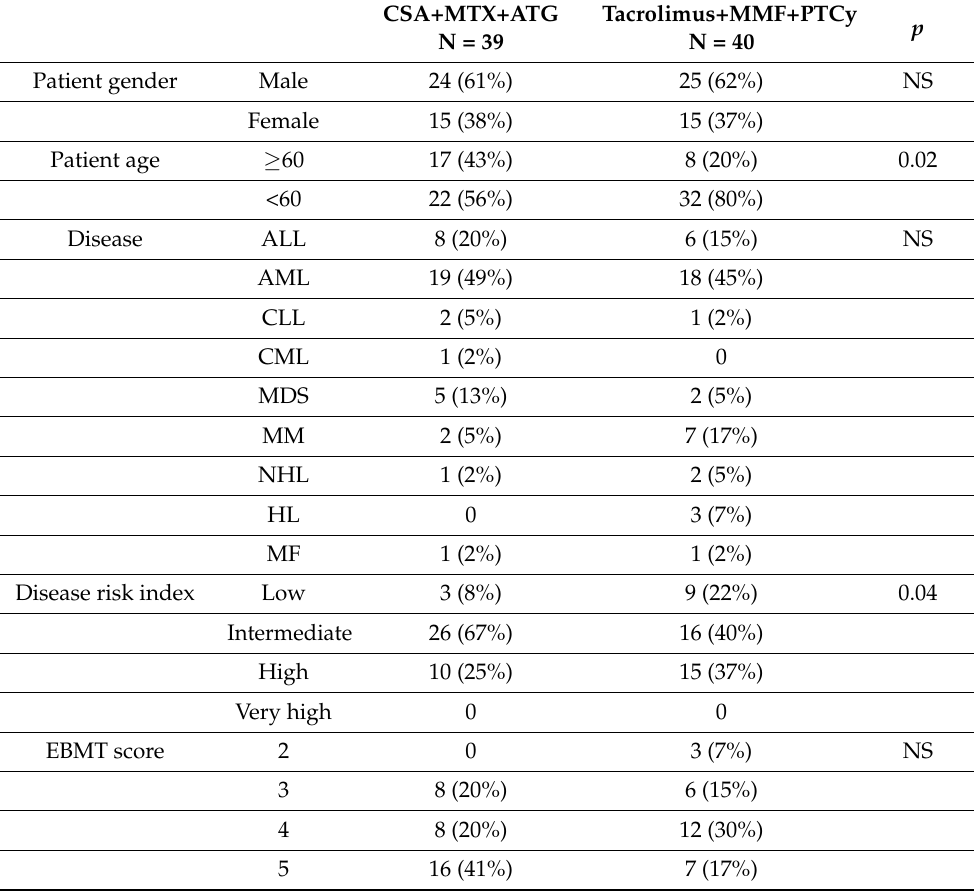
Table 1. Characterization of patients and donors in studied transplants. Demographics of patient– donor-transplants. CSA = cyclosporine-A, MTX = methotrexate, ATG = anti-thymocyte